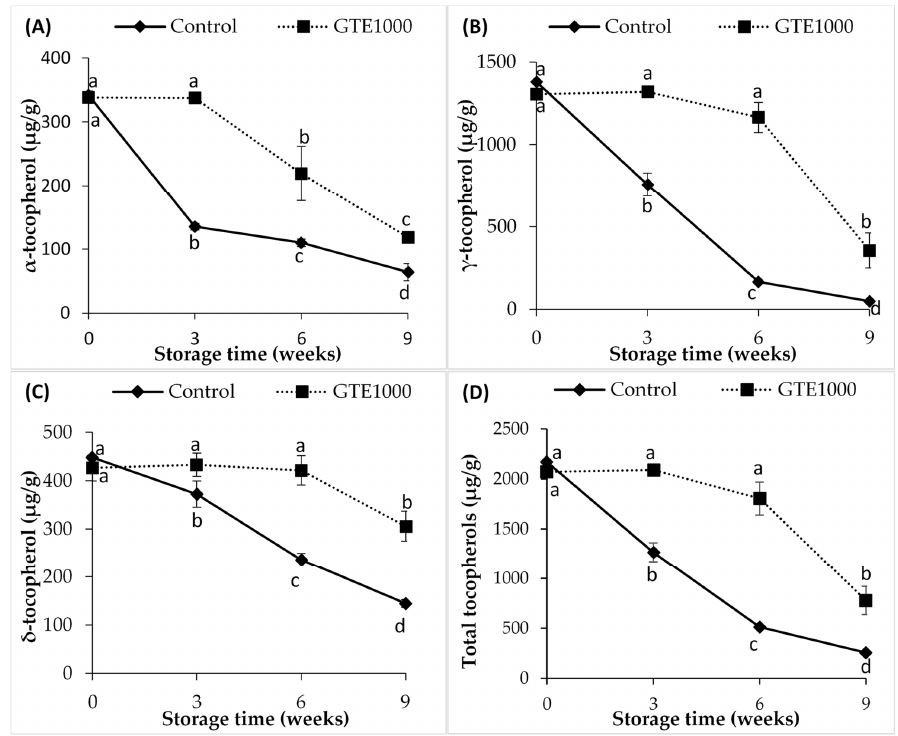
Figure 3. Tocopherol content of DHA-rich oil during 9 weeks of storage at 30 °C. ( A ) α-tocopherol; ( B ) γ-tocopherol; ( C ) δ-tocopherol; ( D ) Total tocopherols. Values are presented as mean ± SD (n = 3). Different letters (a–d) indicate a significant difference ( p ≤ 0.05) during storage for each sample.